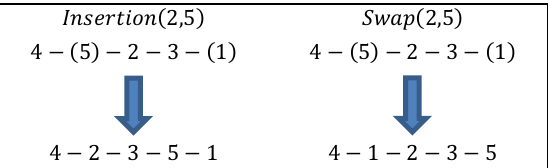
Figure 3. Example of insertion and swap